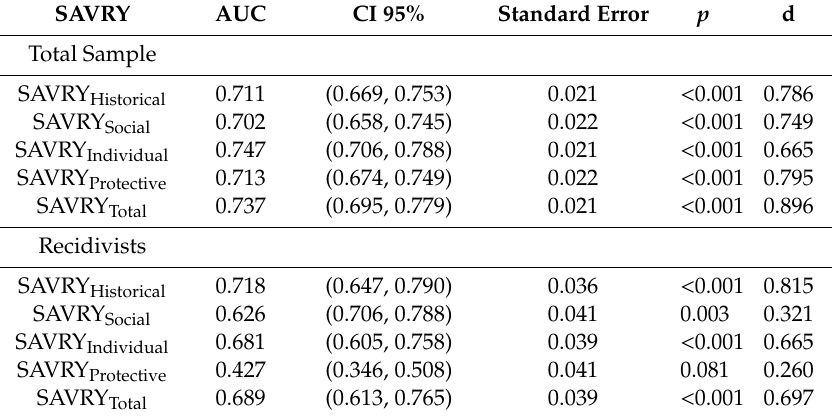
Table 3. AUC (area under the curve) analysis, confidence interval 95% and e ff ect size. SAVRY AUC CI 95% Standard Error p